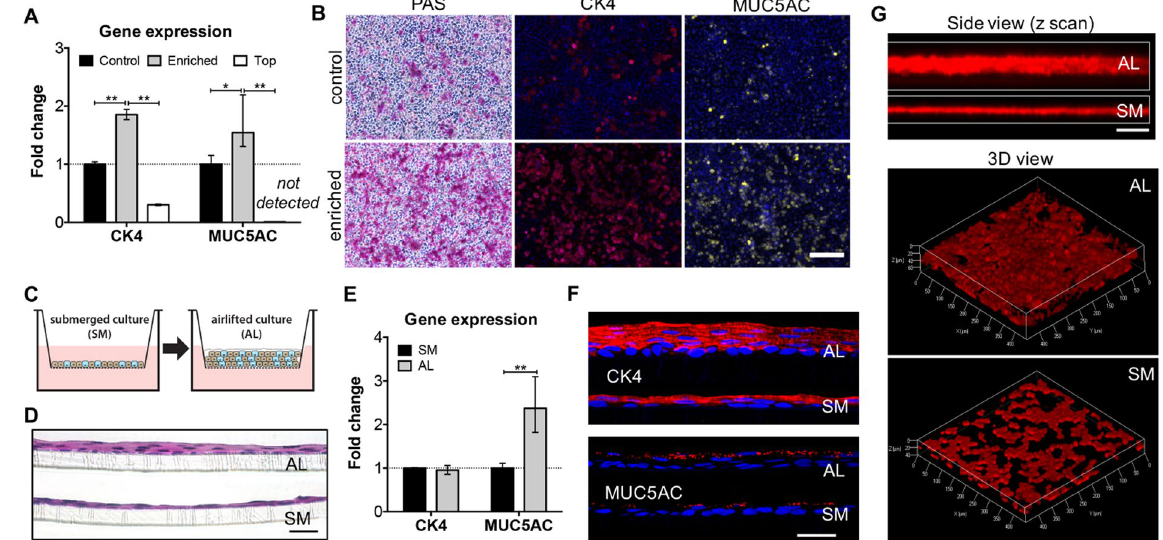
Figure 2. Goblet cell enrichment and airlifting culture of conjunctival epithelial cells (CECs). ( A , B ) Using Percoll density gradient to increase the initial goblet cell percentage in primary conjunctival epithelial cell populations. ( A ) Gene expression (RT-qPCR; fold change is expressed as 2 −ΔΔ CT ) of CECs before (control) and after goblet cell enrichment. CECs were separated into two populations after Percoll gradient separation – top and bottom (enriched). ( B ) PAS staining and immunohistochemistry (IHC) for CK4 and MUC5AC comparing the phenotypes of CECs with or without goblet cell enrichment. Scale bar 200 μ m. ( C ) The schematics for airlifting (AL) and submerged (SM) cultures of CECs based on Transwell insert. H&E staining ( D ) and RT- qPCR ( E ) comparing CECs under AL and SM culture. Scale bar 100 μ m. ( F ) IHC (top: CK4; bottom: MUC5AC) showing the difference in cell phenotypes between AL and SM cultures. Scale bar 50 μ m ( G ) Mucin secretion (stained by Texas Red labeled dextran) visualized by confocal microscope (z scan). Both side view and 3D views are shown. Scale bar 100 μ m. * p < 0.05; ** p <